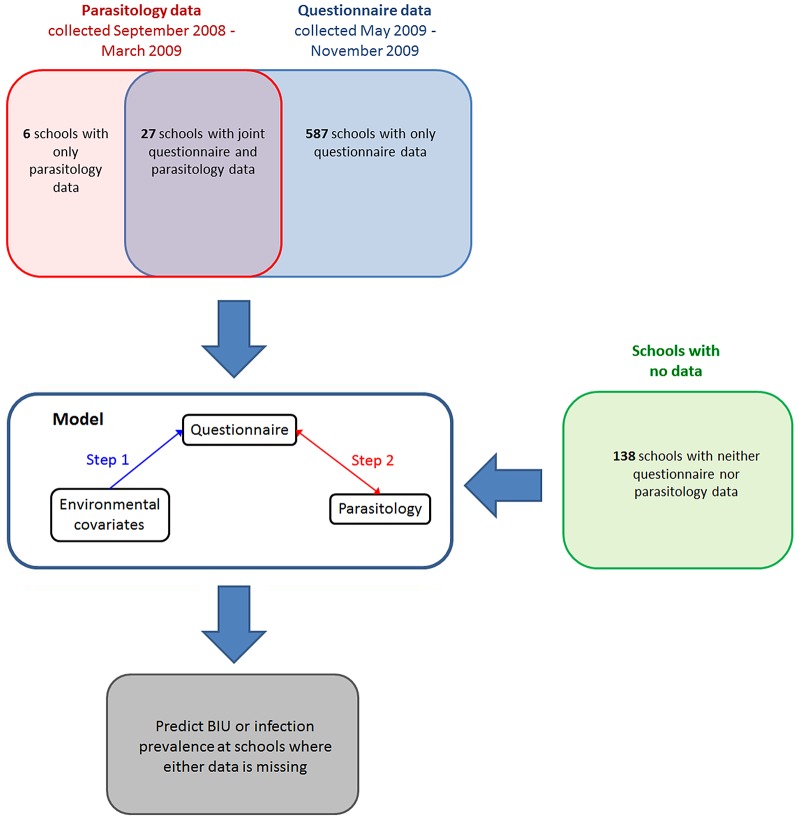
Schematic of the Bayesian model.The model is comprised of three components reflecting the different possible combinations of available data at each location: i) schools for which only questionnaire and environmental data are available and used to inform the parameters governing the relationship between the two (step 1); ii) schools which have both questionnaire and parasitology are used to inform the relationship between the proportion of children reporting blood in urine and the prevalence of S. haematobium (step 2); iii) schools at which only parasitology and covariate data are available are used to further inform the model by identifying parameters values of steps 1 and 2 that best explain the link between environmental covariates and infection prevalence. Within the Bayesian framework, these three components are solved simultaneously, making it possible to find the parameter values for steps 1 and 2 that best fit all available data.